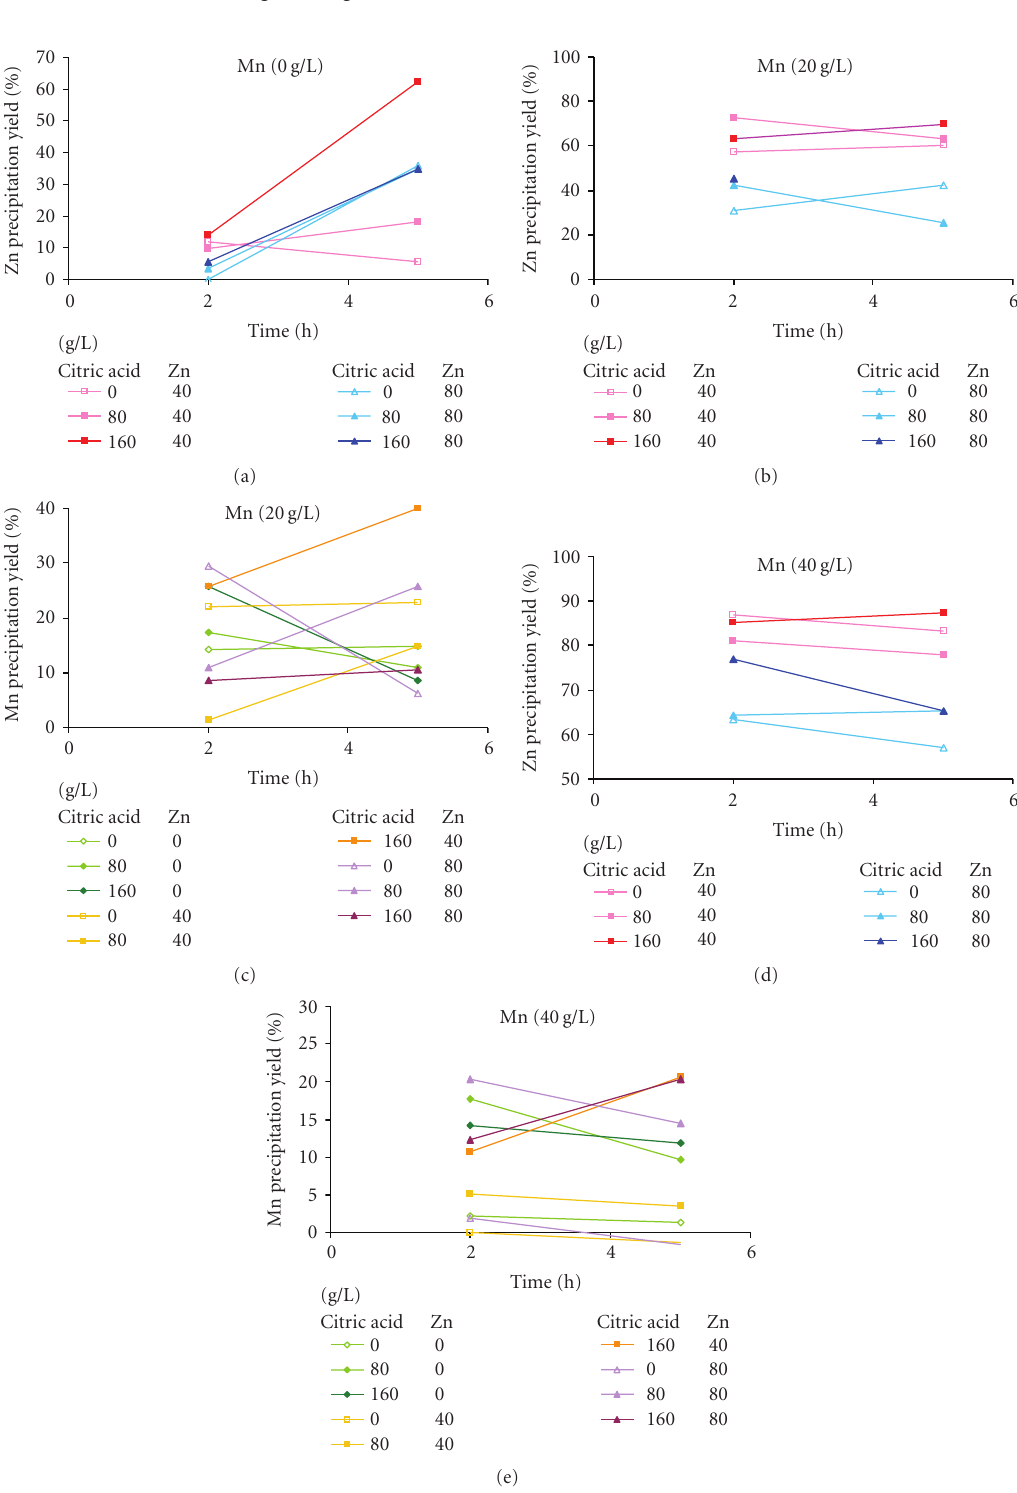
Figure 8: Results of the second series of precipitation